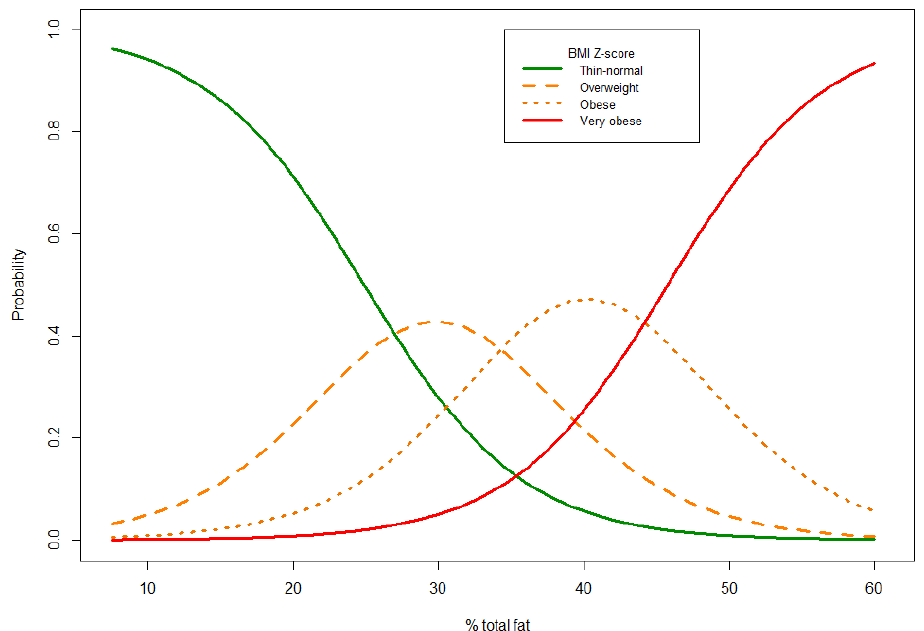
Figure 3. Probability plot for classification into the different BMI Z-score groups according to total fat percentage. Table 1. Optimal cut-off points for fat percentage that differentiate weight groups according to BMI